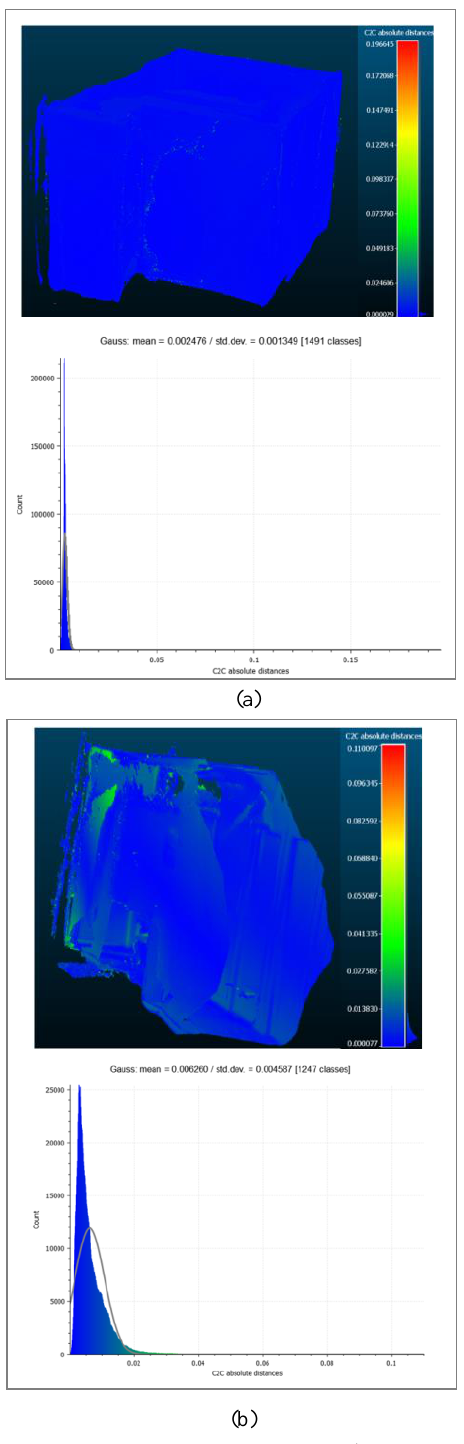
Figure 16. Values and histograms of C2C (cloud to cloud) distances [in m] between the point cloud from a pre-processing of the depth images and the raw point cloud for the case of the scene: (a) Room, (b)